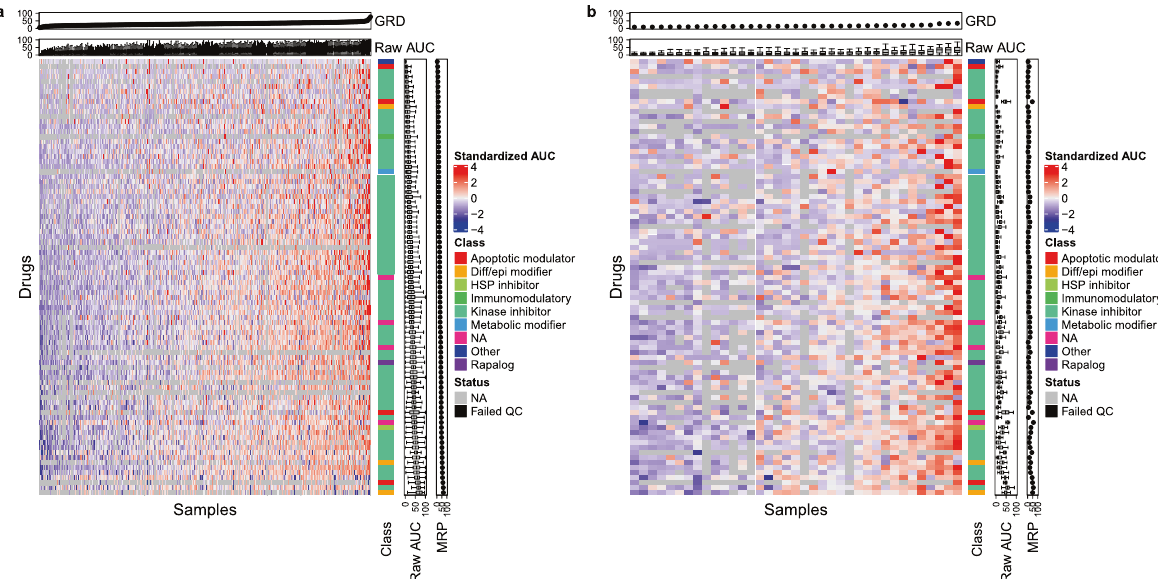
Fig. 1 A patient ’ s ex vivo responses are similar across common drugs. AUCs calculated across patient-derived ex vivo samples (columns) and 87 drugs (rows) common to OHSU ( a ; n = 338) and FIMM ( b ; n = 37) datasets. Red values correspond to higher AUC or more sensitive samples, blue are less sensitive, black are fi ltered, and gray are missing. Standardized AUCs (i.e., with mean zero and standard deviation one across patients) displayed in heatmap. Raw AUCs displayed in top and side panels. General response across drugs (GRD) is mean of raw AUCs for an individual patient over drugs; mean response across patients (MRP) is mean of raw AUCs for an individual drug over patients. Samples ordered by GRD in each dataset. Drugs ordered by MRP in OHSU dataset. One sample displayed per patient, with sample assayed across the highest number of drugs displayed in cases with multiple samples per patient. Class drug class, Diff/epi differentiation/epigenetic, HSP heat shock